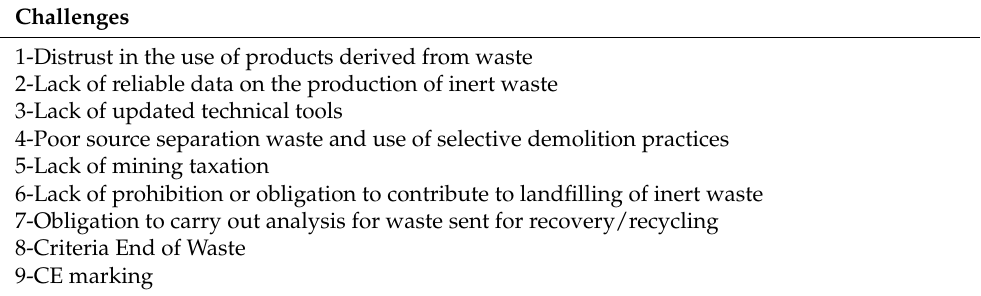
Table 1. Challenges in Italy regarding C&D management Source: Own